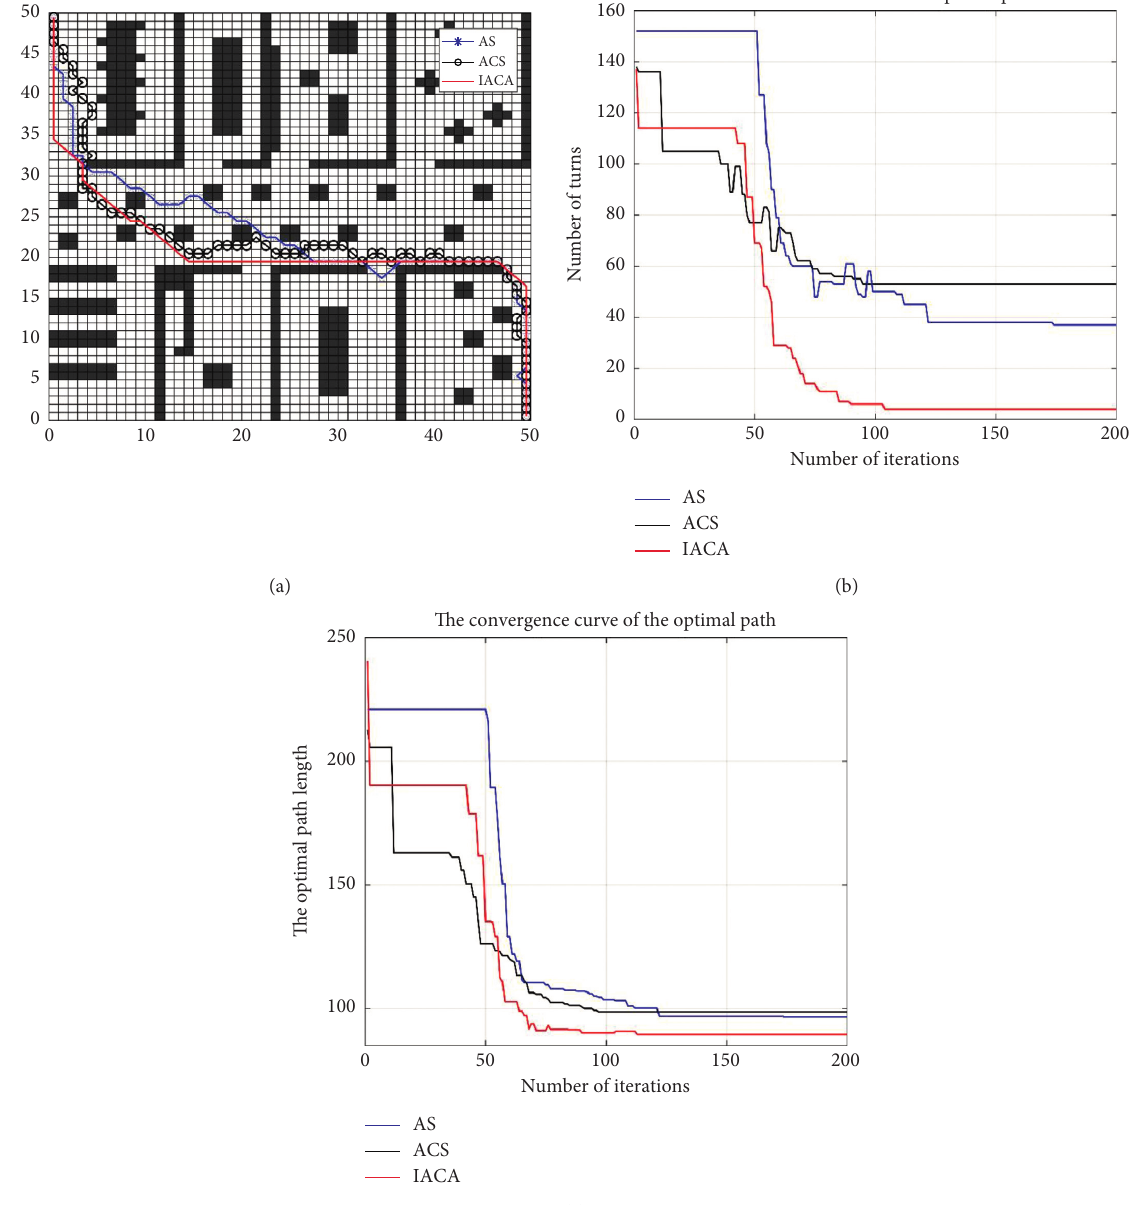
Figure 6: Results of path planning about three algorithms (50 × 50). (a) Path planning in three algorithms (50 × 50). (b) The turns times curve about three algorithms (50 × 50). (c) The convergence curve about three algorithms (50 ×